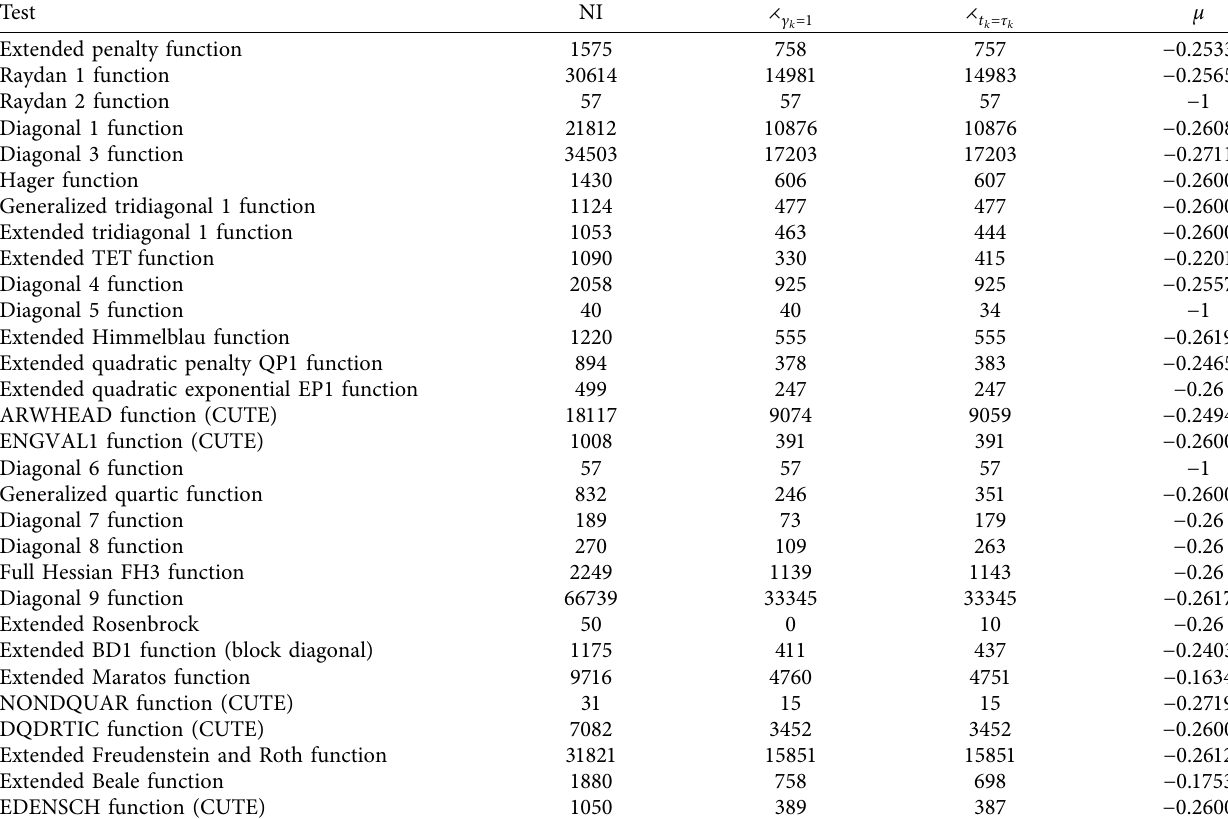
Table 4: Summary test results for behavior of parameters in the MSMDL method.